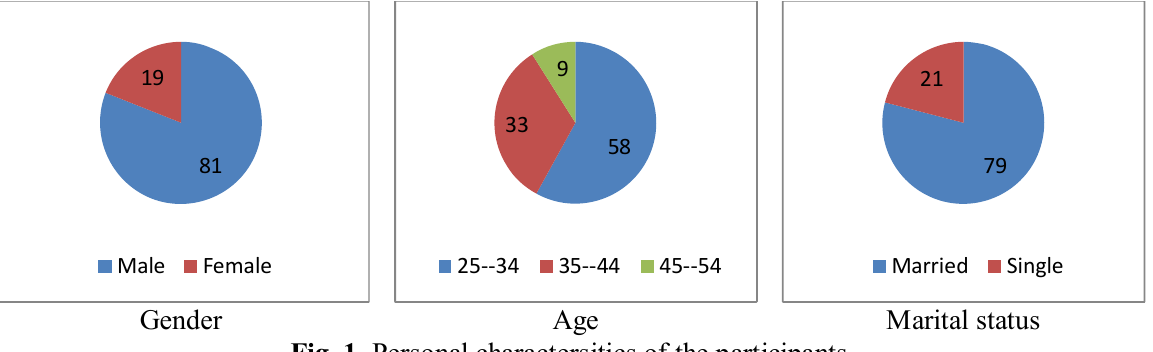
Fig. 1. Personal charactersitics of the